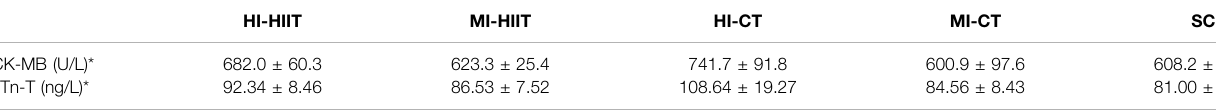
TABLE 2 | CK-MB and cTn-T in each group.